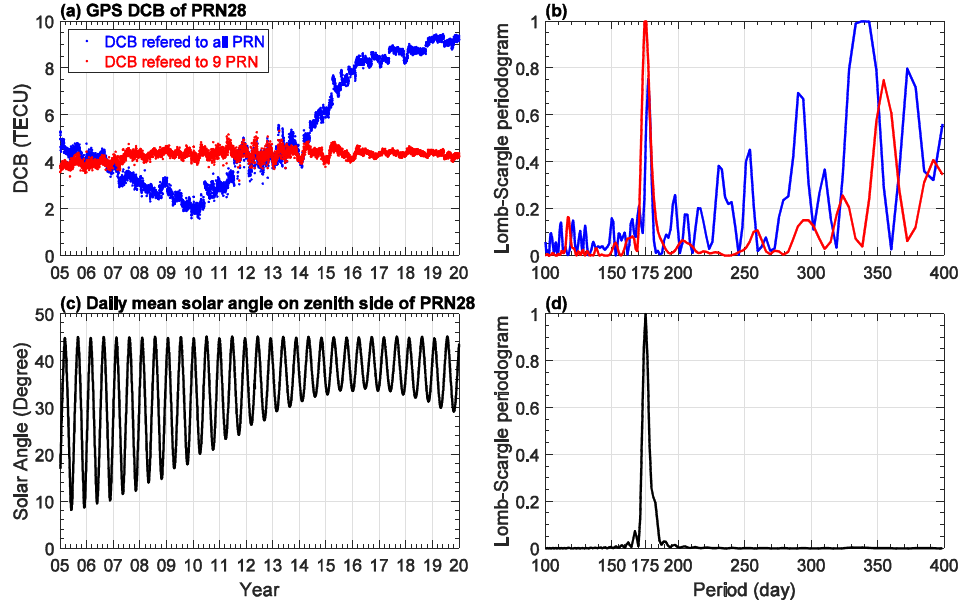
Figure 3. Variations of ( a ) GPS DCB and ( c ) daily mean solar angle on the zenith side of PRN28 (SVN44, Block IIR-A) from 2005 to 2019. The Lomb–Scargle periodograms of GPS DCB and daily mean solar angle are shown on the right panels in subfigures ( b ) and ( d ), respectively. In ( a ) and ( b ), the blue dots denote the original GPS DCBs from IGS, and the red dots denote the reconstructed GPS DCBs under the constraint condition imposed on the GPS DCBs of 9 continuously operating satellites. In ( b ) and ( d ), the power spectral density is scaled by the maximum value within the interest periods.